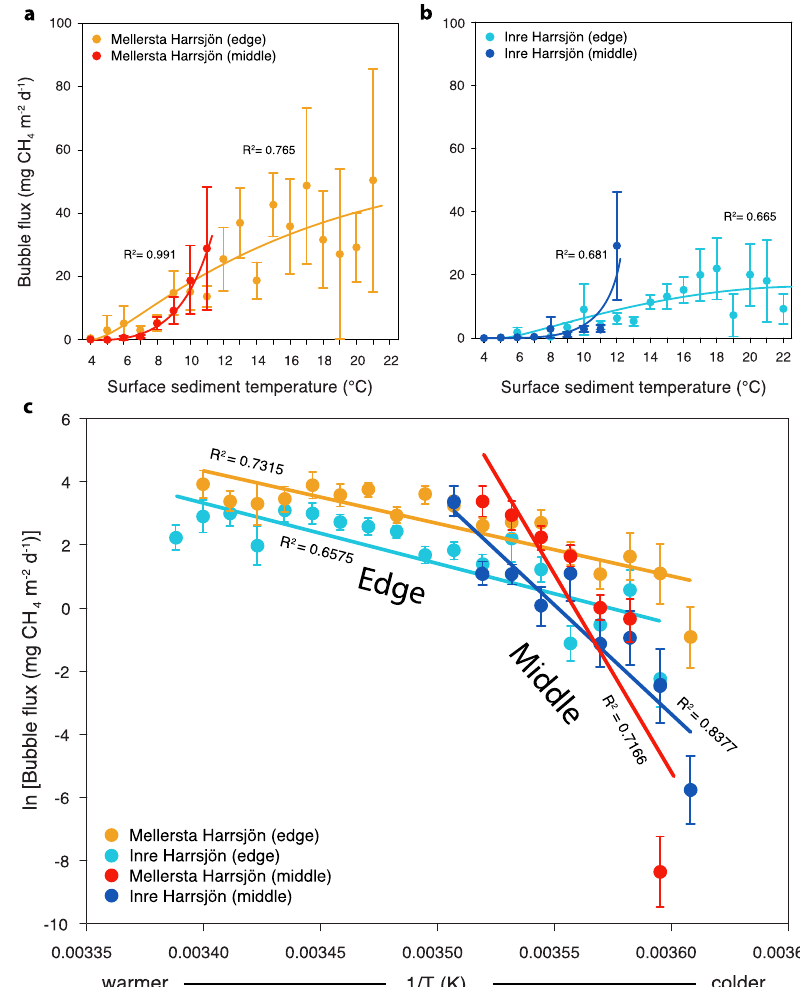
Fig. 1 Temperature responsiveness of ebullitive methane fl ux from two post-glacial lakes. Ebullitive CH 4 fl ux as a function of surface sediment temperature (data were binned in 1 °C intervals; see Methods) from June to September 2009 – 2014 for the edge vs. middle regions of a Lake Mellersta Harrsjön (MH) (MH edge — n = 1581, MH middle — n = 795 independent ebullitive CH 4 fl ux measurements) and b Lake Inre Harrsjön (IH) (IH edge — n = 2318, IH middle — n = 432 independent ebullitive CH fl ux measurements). Error bars in a and b are 95% con fi dence intervals, fi t lines are 2nd-degree 4 polynomials, and points are means. c Arrhenius plots of the data in a and b ( n = 5126 independent ebullitive CH 4 fl ux measurements); ln(bubble CH 4 fl ux) vs. the inverse surface sediment temperature in K. Points are means and error bars are 95% con fi dence intervals. Data are color-coded by the lake and by edge (littoral) and middle